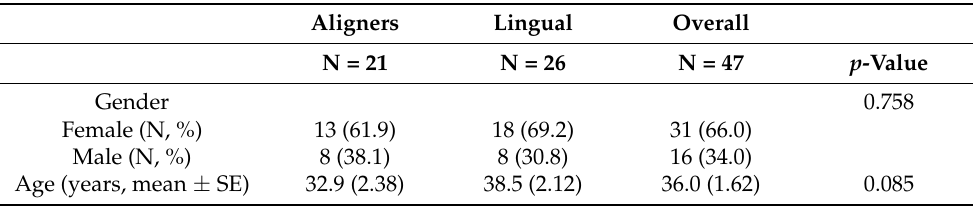
Table 1. Demographic characteristics by group.